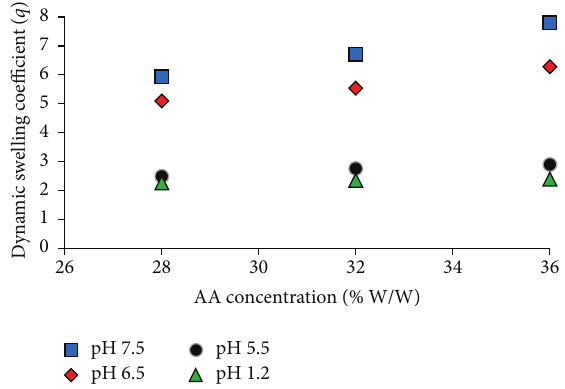
Figure 4: Dynamic swelling coefficient of AA/Gelatin hydrogels with different concentration of acrylic acid (28, 32, and 36 g) using EGDMA as cross-linking agent (0.7%) of acrylic acid in 0.05 M USP phosphate buffer solutions of different pH values at 37 ∘ C.